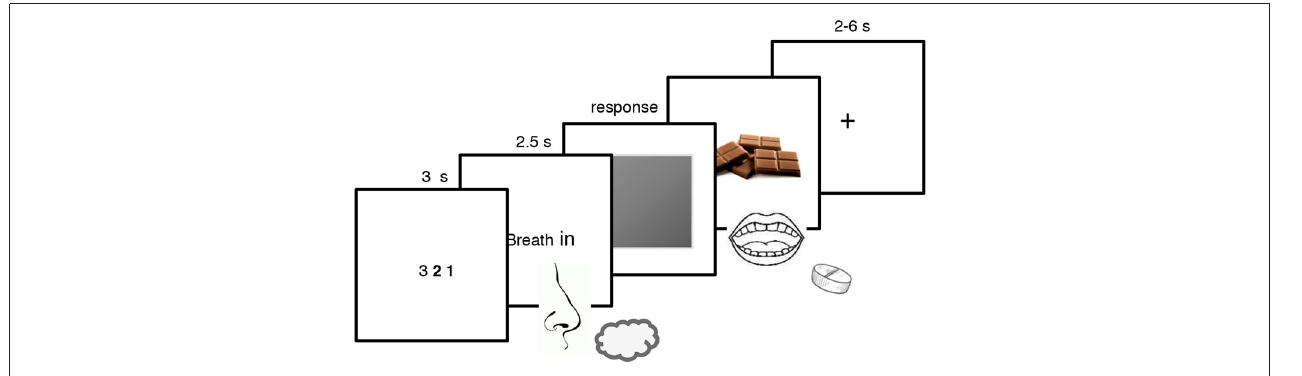
odor and pressed on a keyboard to remove the gray patch and discovered whether the odor was associated with the rewarding chocolate or not. The CS + was associated with the reward whereas the similar CS + , the CS − and the similar CS − were